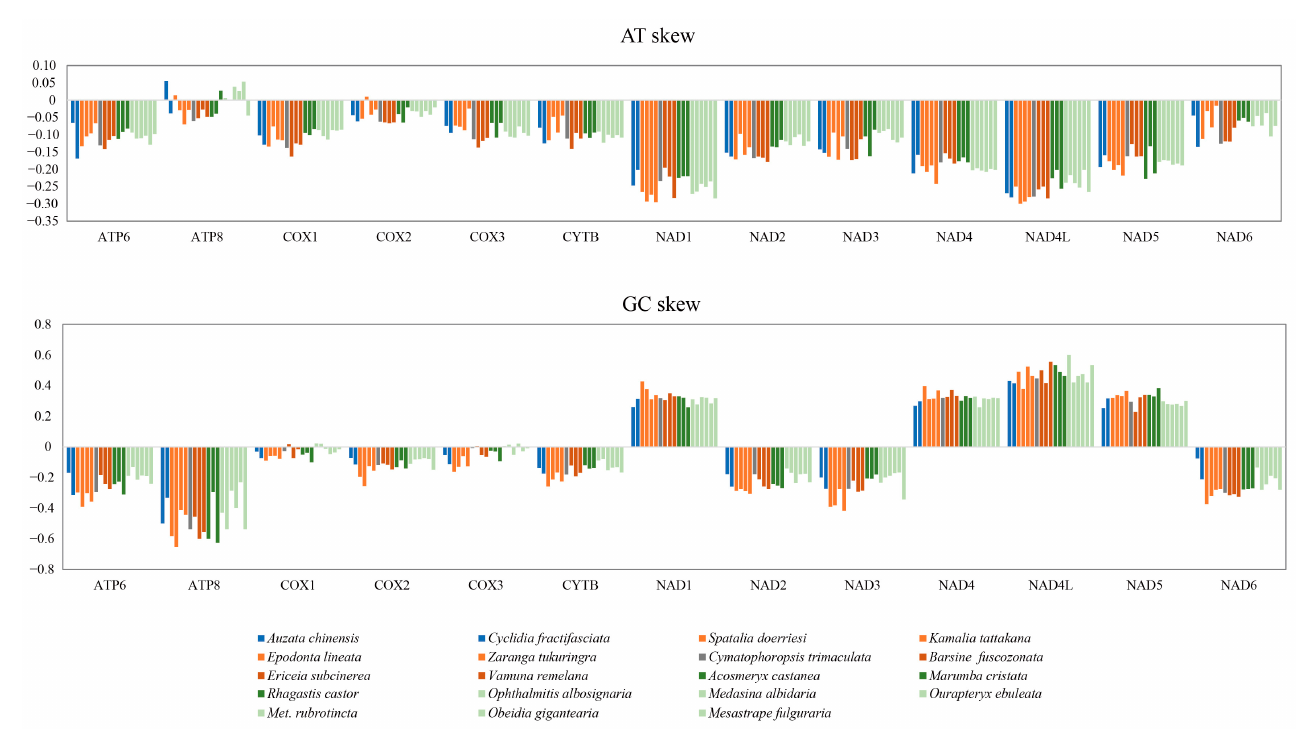
Figure 2. AT and GC skew on individual PCG gene in 19 moth mitogenomes.